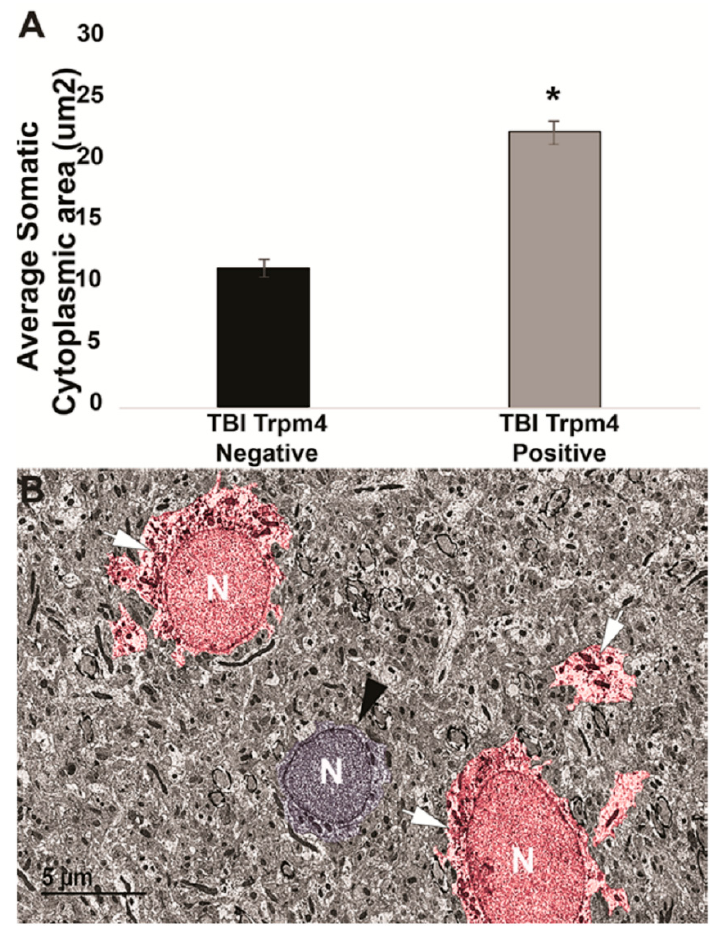
Figure 2. TRPM4 mediates astrocyte swelling after diffuse TBI. ( A ) Bar graph depicting the average area of the somatic cytoplasm surrounding the nucleus. TRPM4 expression nearly doubled the astrocyte cytoplasmic area, compared with TRPM4 -negative astrocytes. ( B ) Representative electron micrograph of astrocytes from the hippocampal gray matter 4 weeks post–central fluid percussion injury labeled against TRPM4 (white arrows; red pseudo color). The arrows indicate immunoreactivity against TRPM4. The astrocyte in the middle of the electron micrograph (black arrow head; blue pseudo color) is a TRPM4-negative astrocyte located between two TRPM4-positive astrocytes. N indicates the nucleus of each cell. Traumatic brain injury (TBI), three animals TRPM4-negative, n = 57 cells; TRPM4-positive, n = 110 cells. Analysis of variance; error bars represent standard error of the mean. * p < 0.05. Scale bar 5 µ m. From [38].